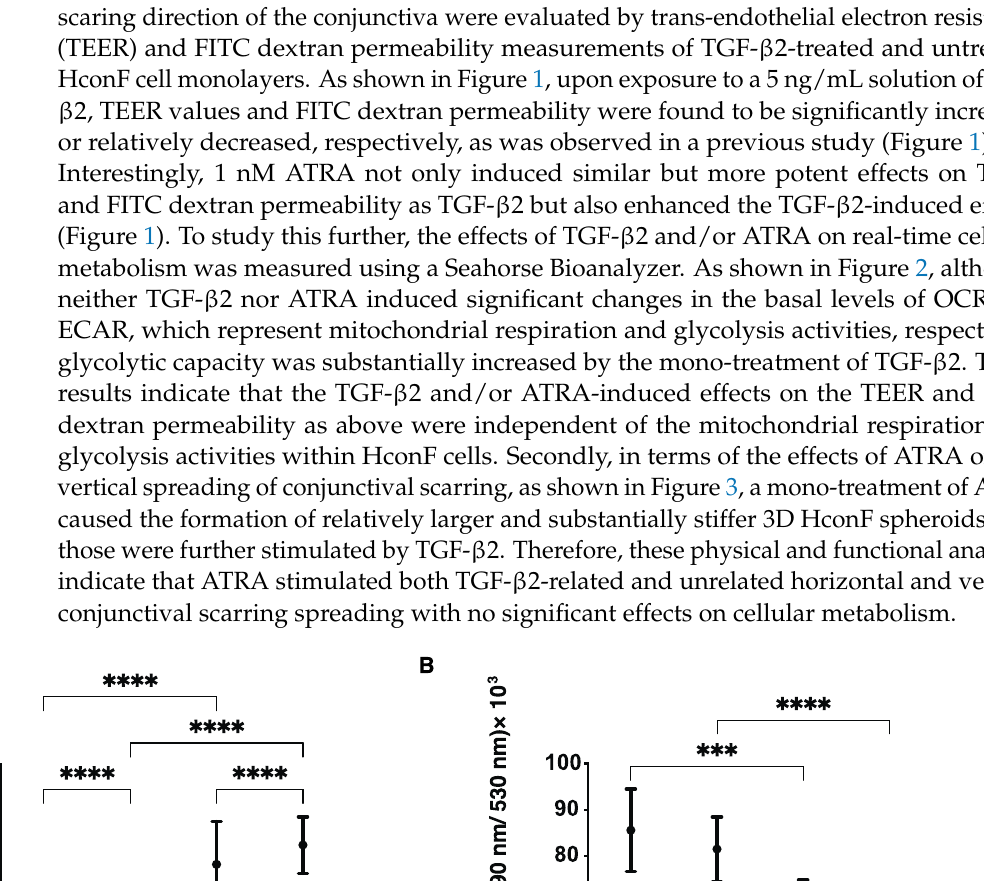
Figure 2. Effects of ATRA toward the mitochondrial glycolytic cellular functions of HconF 2D cells treated with TGF- β 2 on untreated 2D HconF cells. Two-dimensional HconF cells untreated and treated with TGF- β 2 (TGF β , 5 ng/mL) were subjected to a seahorse real-time metabolic function analysis in the absence or presence of 1 μ M ATRA. Panels ( A , B ): Basal OCR and ECAR were meas- ured and then further measured by subsequent supplementation with a complex V inhibitor,